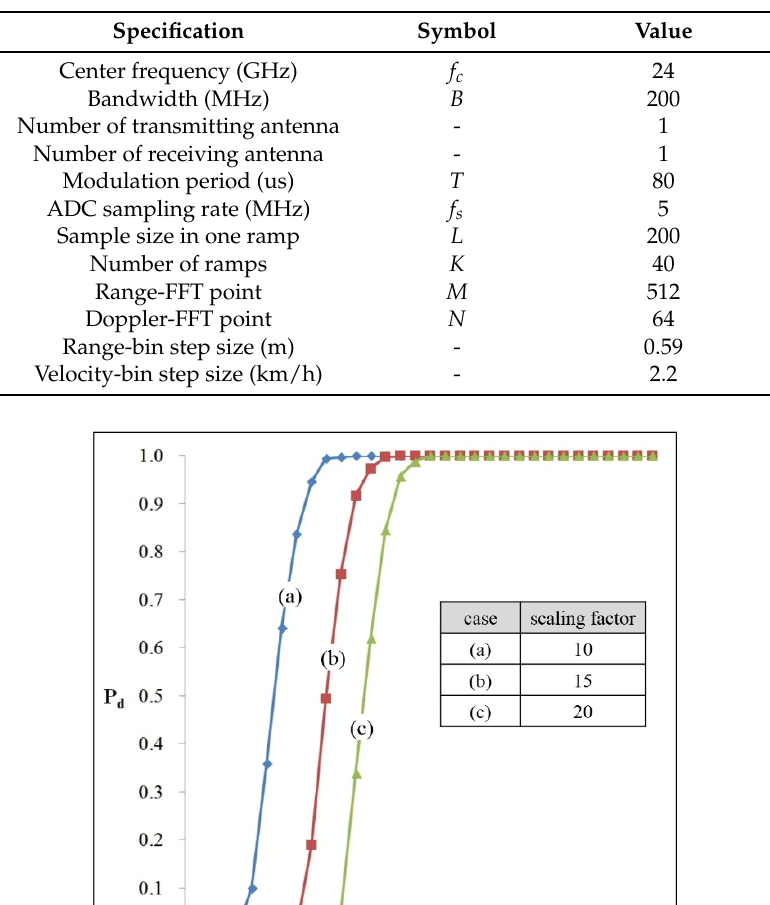
Table 1. Parameters of the radar system used in this study.